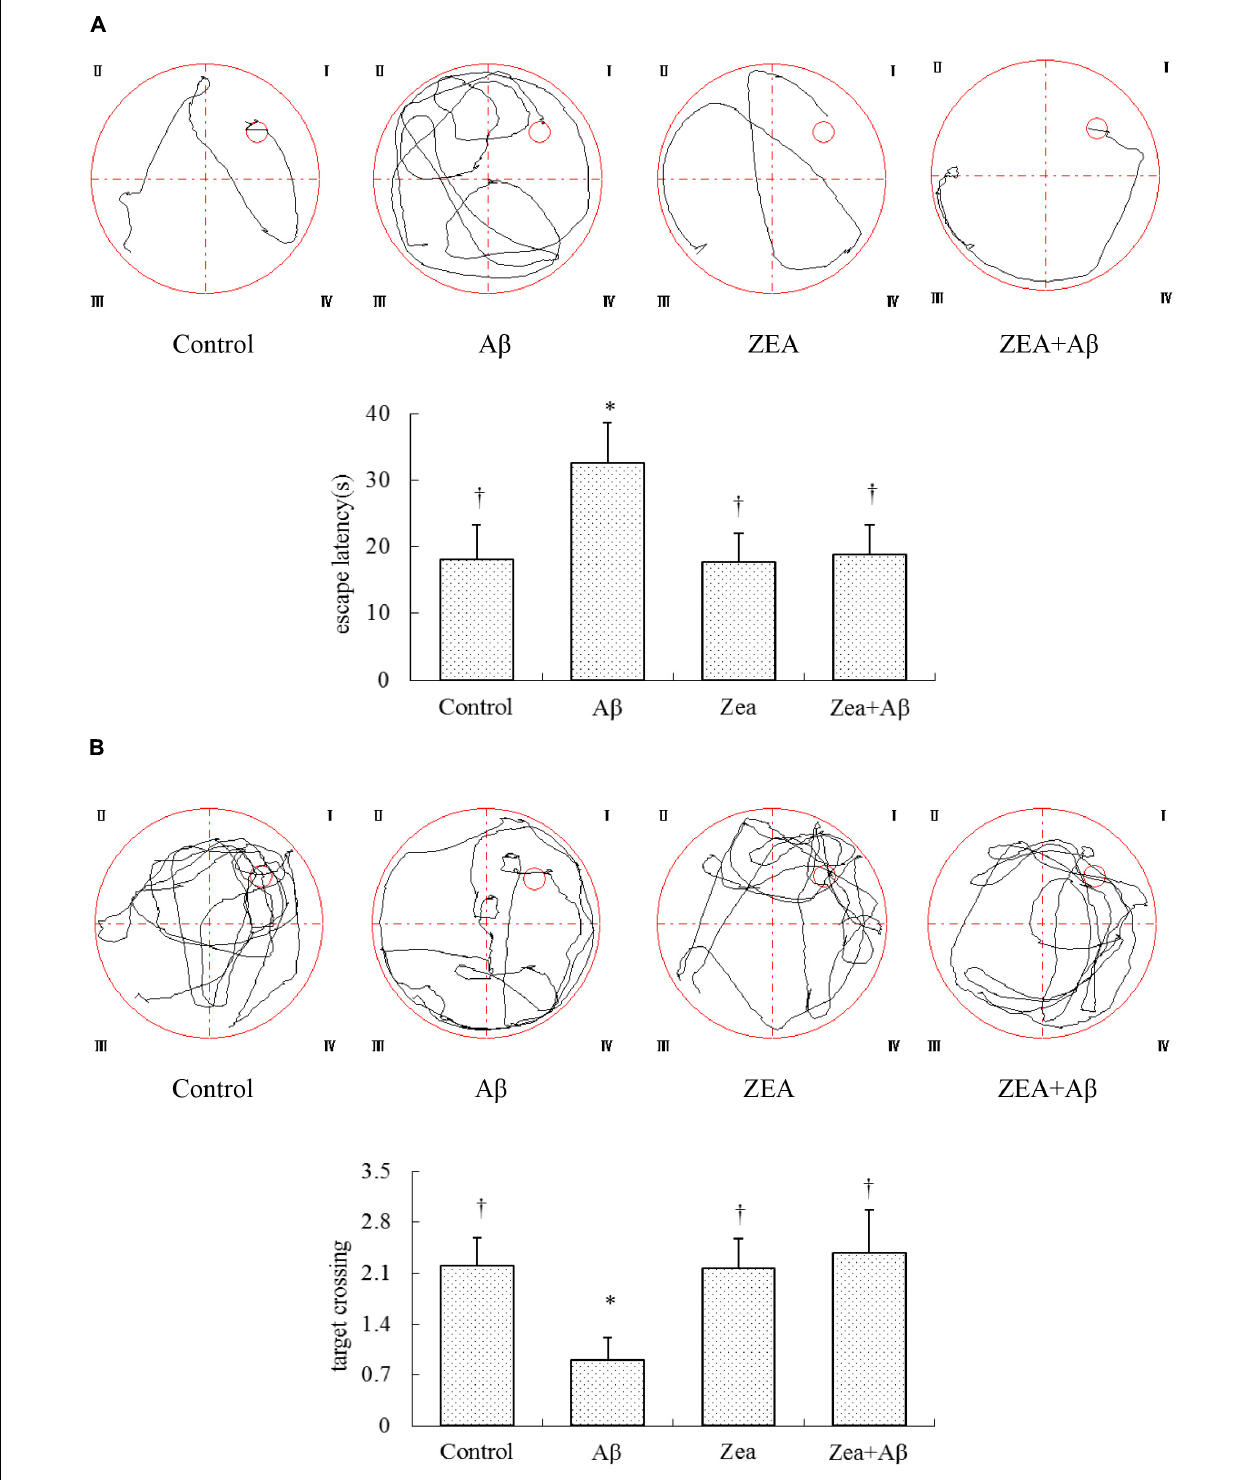
FIGURE 2 | Neuroprotective effects of ZEA on escape latency (A) and frequency of rats crossing the position of the platform (B) in learning and memory impairment rats induced by A β 1–42; Morris water maze test was taken from CMC-Na i.g. + N.S injected into lateral cerebral ventricle (LCV) group (Control group); CMC–Na i.g. + A β 1–42 injected into the LCV group (A β group); ZEA i.g. + N.S injected into the LCV group (ZEA group); ZEA i.g. + A β 1–42 injected into the lateral cerebral ventricle group (ZEA + A β group) ( n = 12 per group). All the data were shown as mean ± SD, and analyzed by the one-way ANOVA test [ post hoc (LSD) test]. ∗ Significantly different from the Control group ( p < 0.05). † Significantly different from the A β group ( p < 0.05).